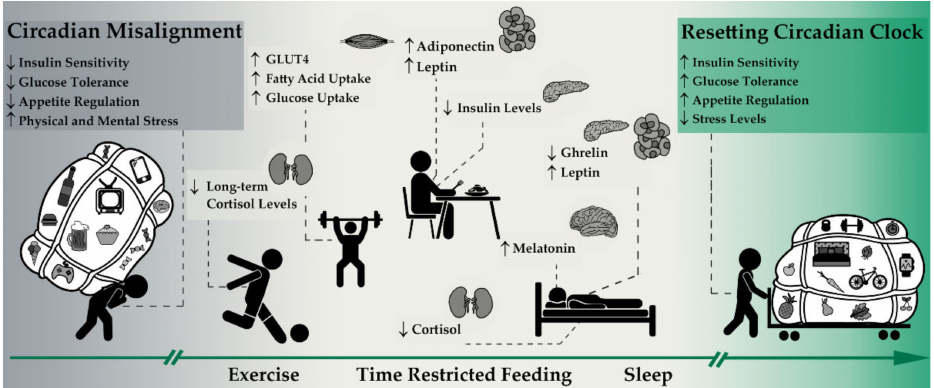
Figure 2. Resetting the circadian clock. Sleep, time restricted feeding (TRF) and exercise affect circadian rhythmicity helping to resynchronize the central with peripheral pacemakers by influencing different metabolic pathways. Exercise particularly affects peripheral processes in muscle and adipose tissues and influences glucose homeostasis. In addition, regular exercise can reduce stress levels by influencing cortisol levels. Besides, glucose homeostasis and hunger/satiety hormones are controlled by TRF. Despite these peripheral influences, sleep also affects central rhythmicity through a direct impact on melatonin and cortisol